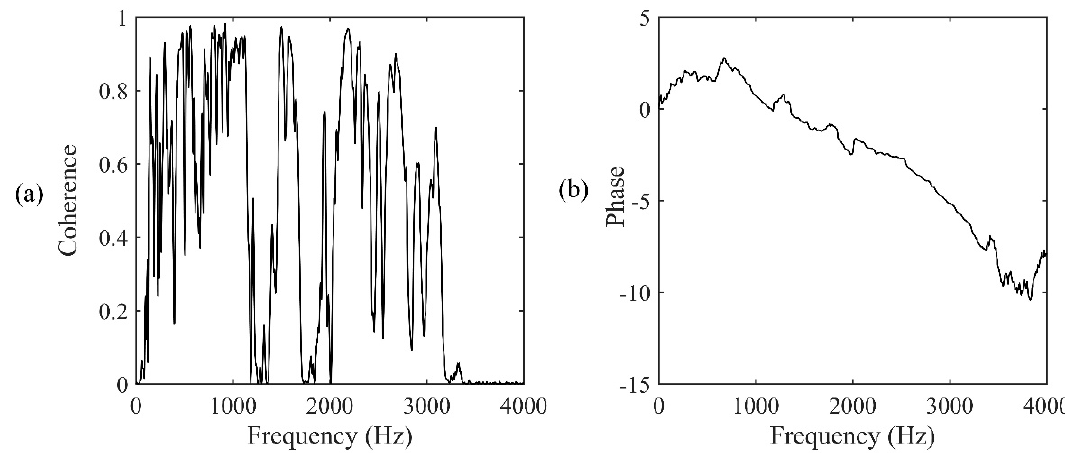
Figure 18. Frequency analysis of the signals measured at A1&A3: ( a ) Coherence function; ( b ) phase spectrum.